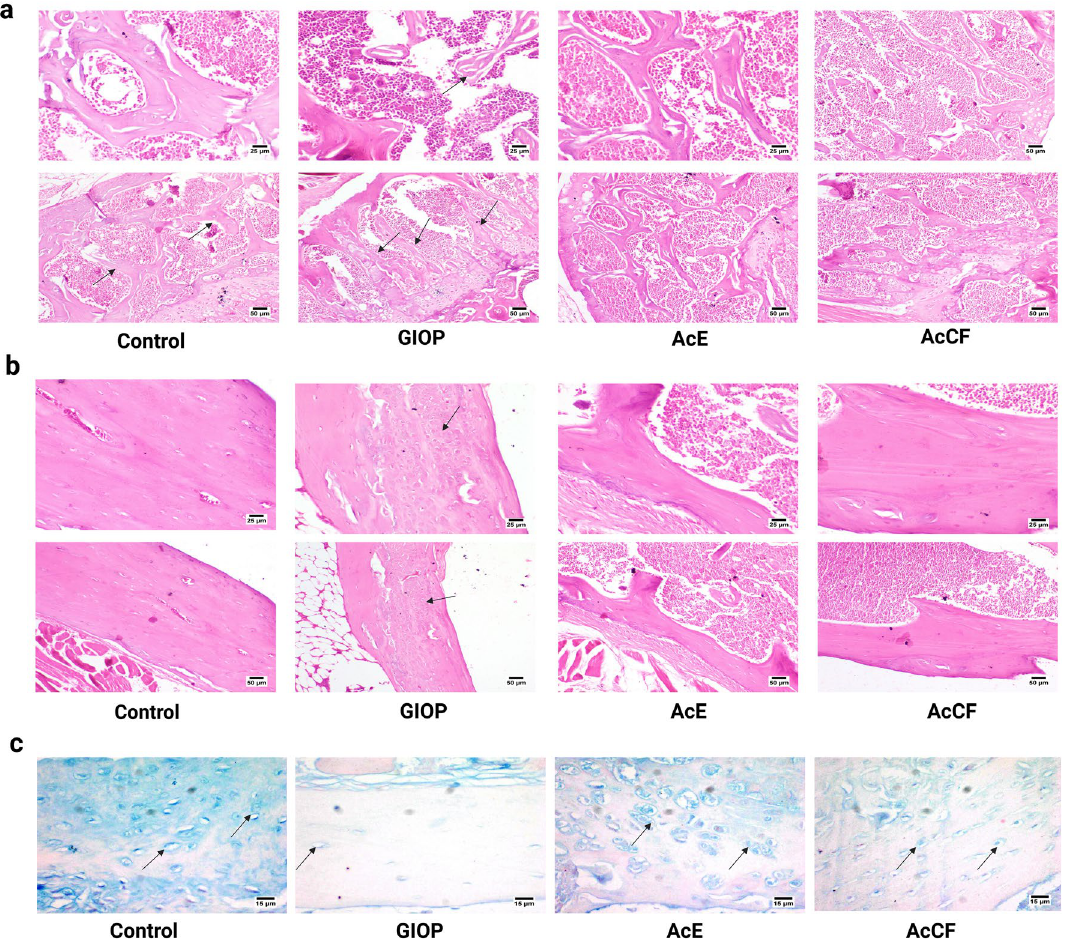
Figure 3. Histological analysis of the trabeculae and cortical bones in the femur of control, GIOP, AcE and AcCF. ( a ) Photomicrograph of bone trabeculae (arrows) (H&E). Control group showing normal trabeculae. GIOP group showing thin bone trabeculae with defective mineralization. AcE group showing normal bone trabeculae. AcCF group showing mild thinning in the bone trabeculae. ( b ) Photomicrograph of compact bone (H&E). The Control group showed normal compact bone. GIOP group showing defective mineralization of compact bone (arrow). AcE group showing normal compact bone. AcCF shows normal compact bone. ( c ) Photomicrograph of bone stained with Alcian blue. Control group showing normal GAGs deposition. GIOP group showing marked reduction in GAGs deposition. AcE group showing increased GAGs deposition. AcCF- group showing a mild increase in GAGs deposition. Notably, AcE shows better GAGs deposition. Arrow: GAGs